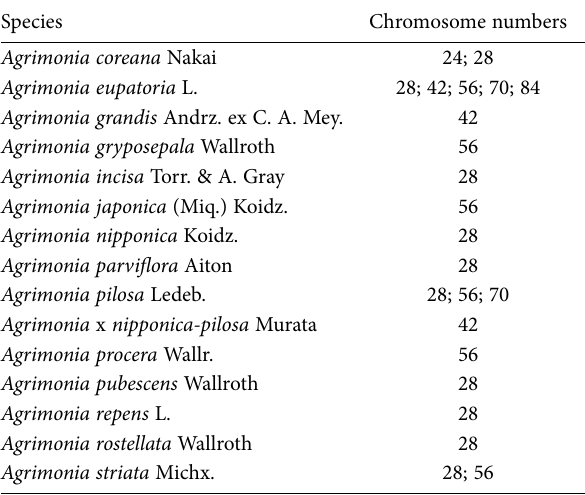
Table 2. Chromosome numbers in the genus Agrimonia L. (Chung 2008; Angelo and Boufford 2012; Rice et al .